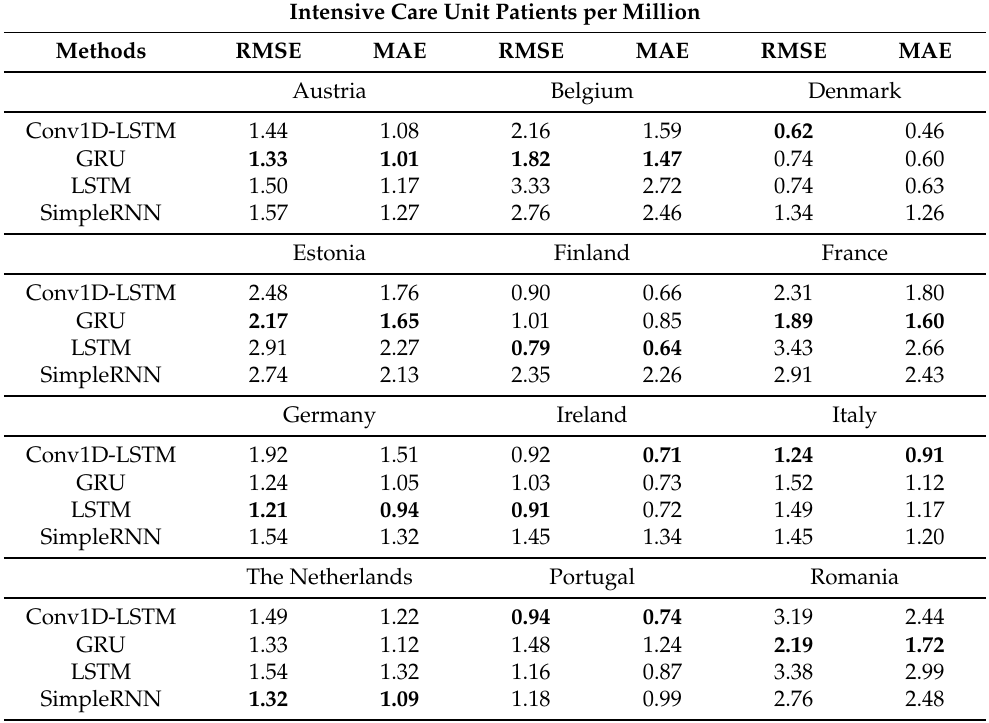
Table 5. Errors for ICU admissions of the patients per million of the population for each country per method. Bold values show the minimum error achieved per